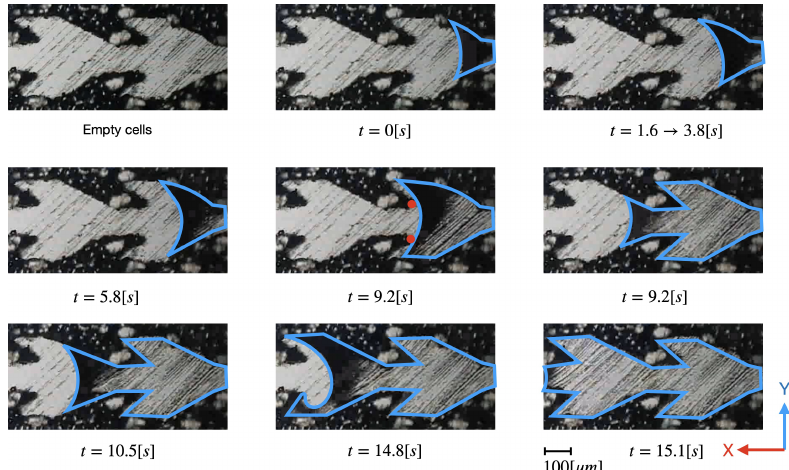
Figure 8. Evolution of water transport in channel type A in the positive direction. Experimental conditions are the same as in Figure 5. Many chemical defects slow down the dynamics. Water is delimited by a blue line for better visibility. Red dots of the snapshot at t = 9.2 [ms] highlight the acute edges discussed in the